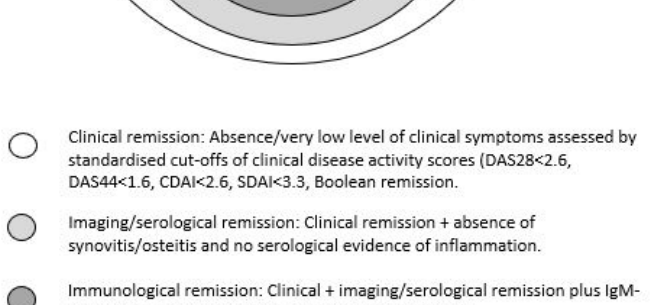
Figure 1. Shell model of remission states adapted from Schett et al. [7].